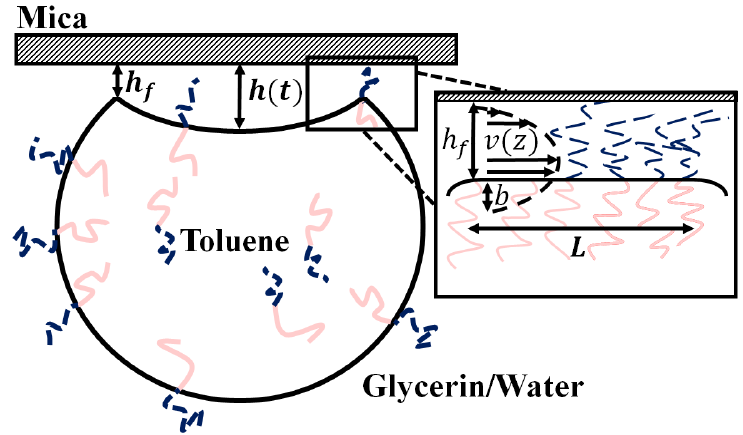
Figure 2. A side view schematic of a buckled PS-PEO covered emulsion drop pushed against a flat mica wall highlighting the slip length b at the emulsion boundary and the width L of the polymer brush at the inflection point.